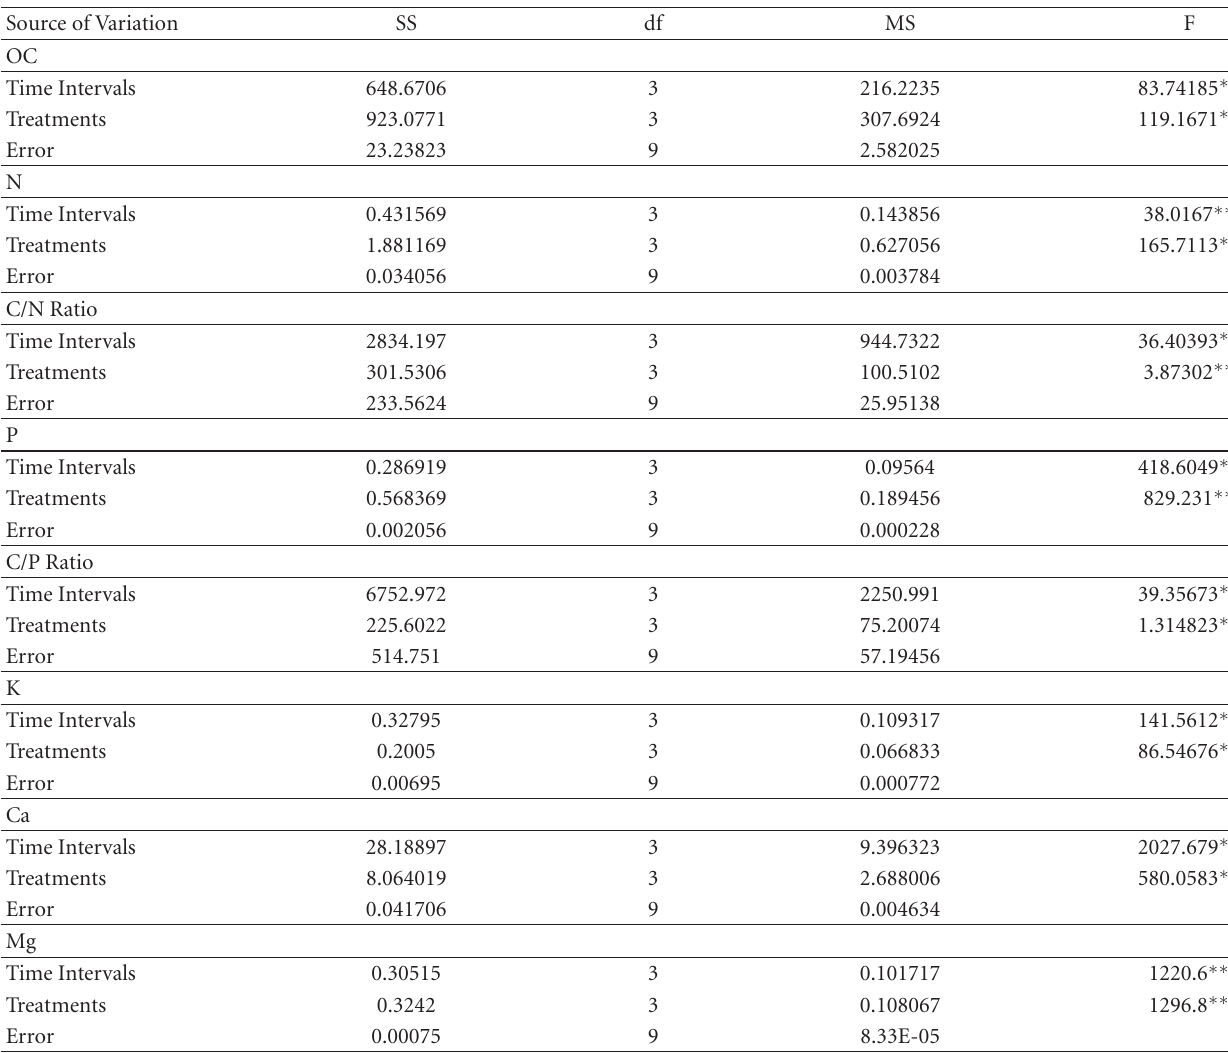
Table 3: ANOVA of di ff erent nutrients of vermicomposts produced by three species of earthworms and compost (Treatments) of Market Waste across di ff erent time